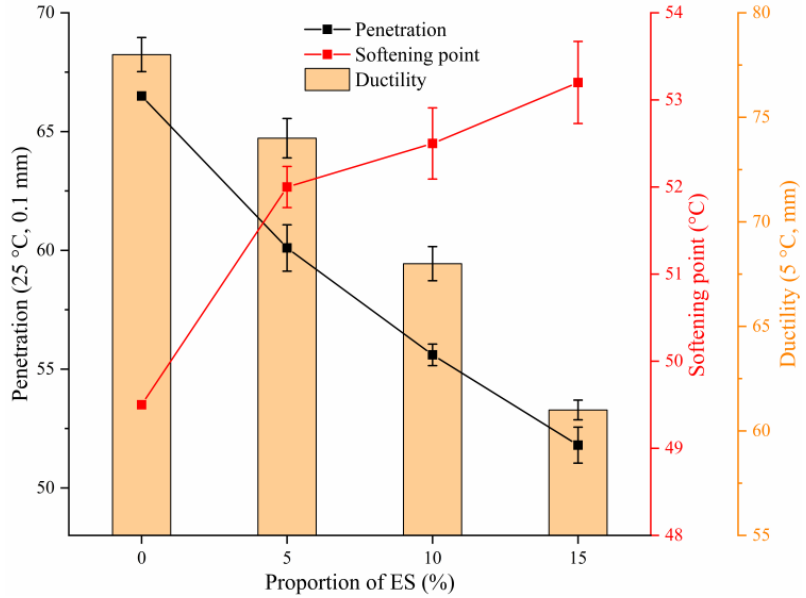
Figure 6. Conventional performance of asphalt results.